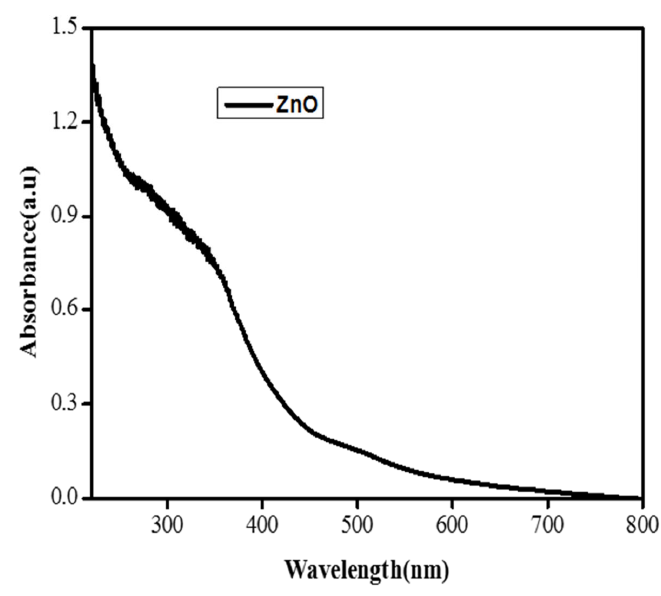
Figure 2. UV pattern of the ZnO nanoparticles.